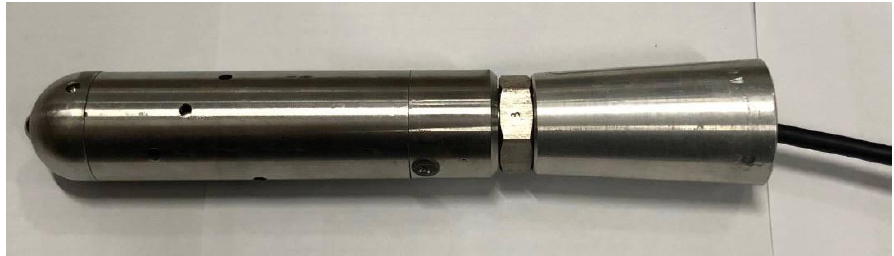
Figure 5. Photograph of the assembled FBG borehole deformation sensor.